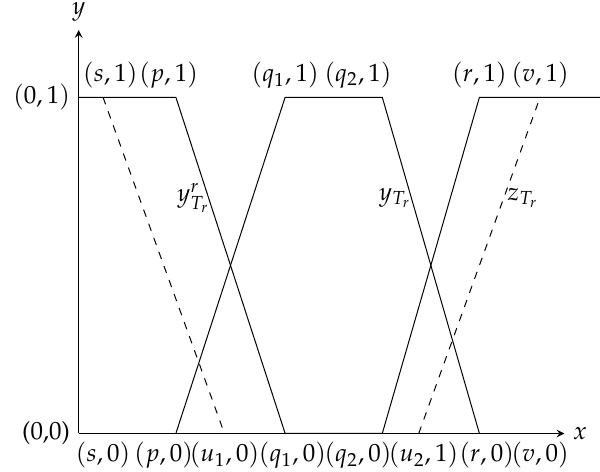
Figure 2. Intuitionistic fuzzy set of trapezoidal